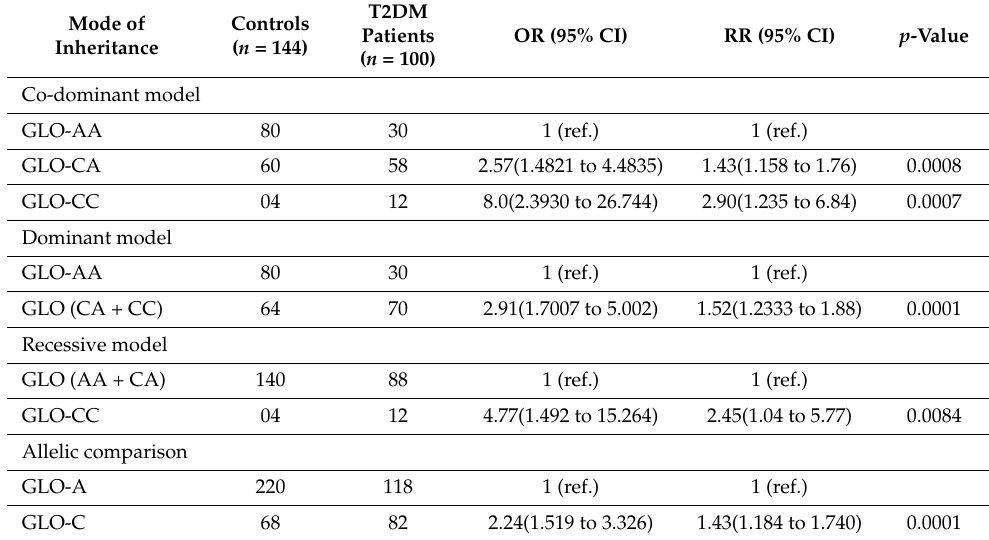
Table 5. Association of GLO-I rs2736654 C>A (GLO rs4647 A>C) gene variation with T2DM.